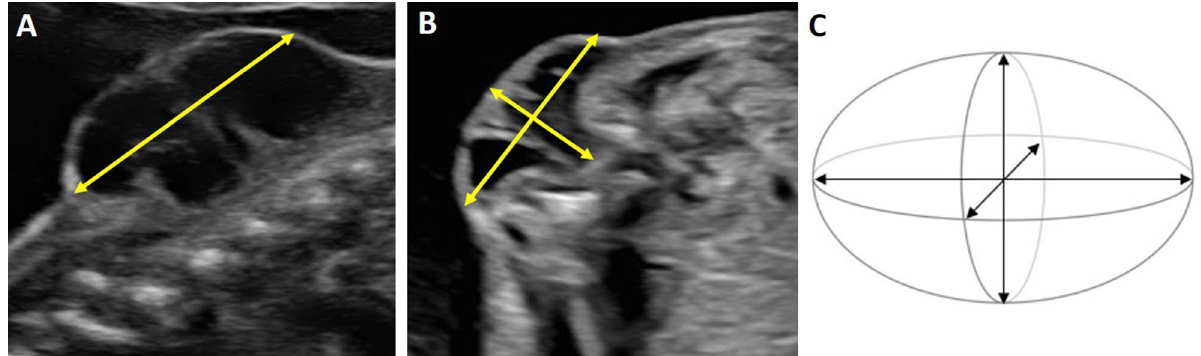
Figure 1. Volume of the myelomeningocele: ultrasound measurements. ( A ) Sagittal view of a myelomeningocele at 20 weeks of gestation: length. ( B ) Transversal view of a myelomeningocele at 20 weeks of gestation: width and depth. ( C ) Volume of the myelomeningocele: prolate ellipsoid volume: length × width × depth ×